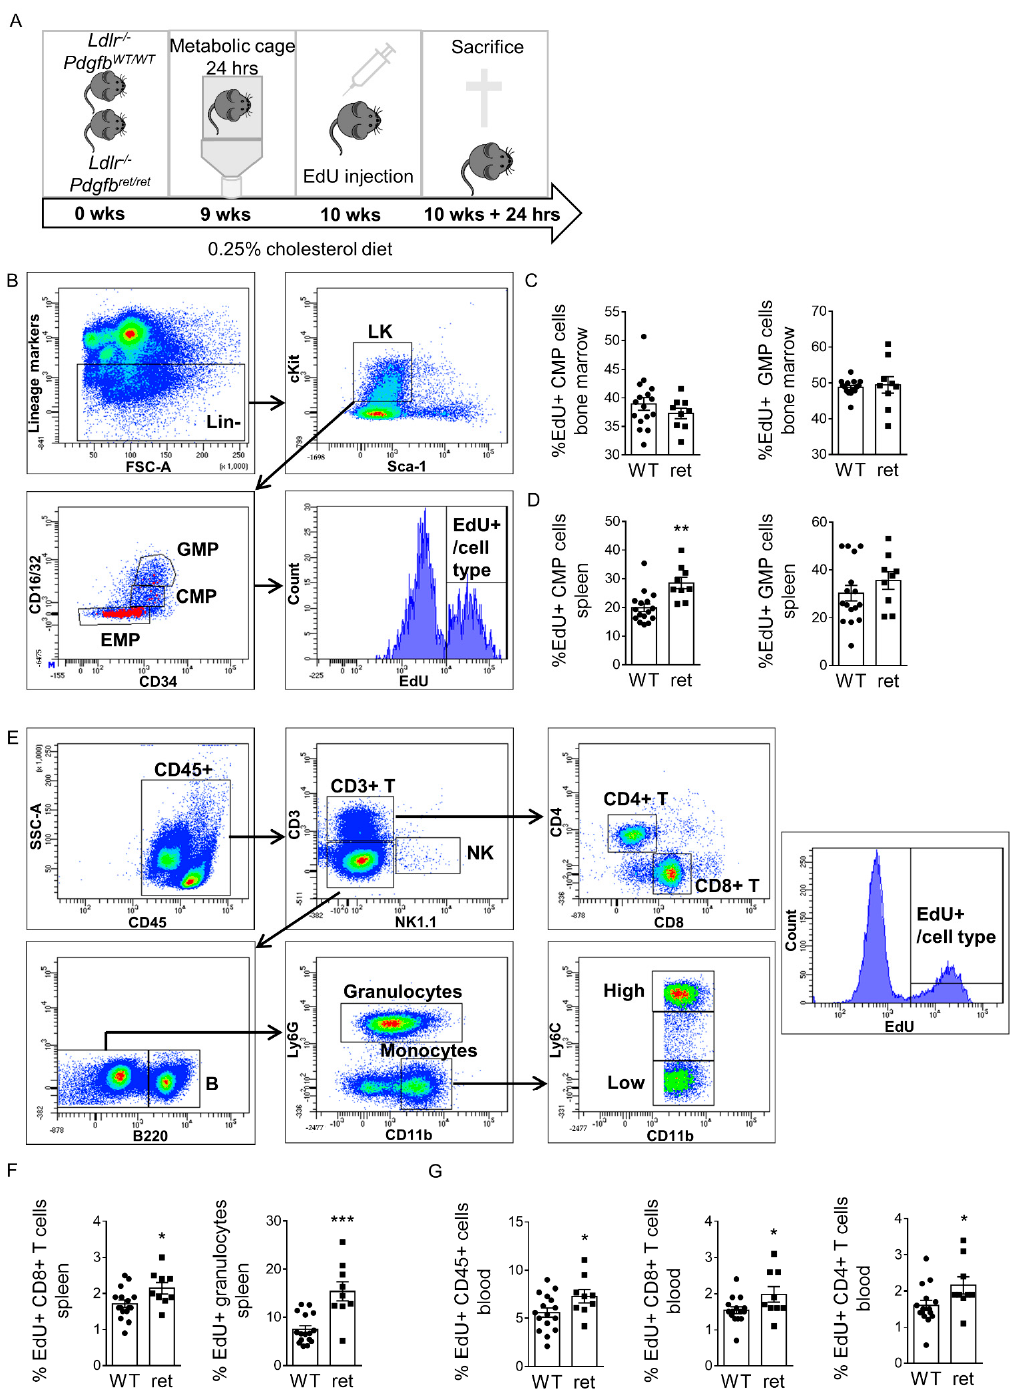
Figure 5. Increased extramedullary hematopoiesis and proliferation of leukocytes in Pdgfb ret / ret mice. ( A ) Setup of second mouse experiment using Ldlr -/- Pdgfb WT / WT ( n = 16) and Ldlr -/- Pdgfb ret / ret ( n = 9) mice. ( B ) Flow cytometry gating strategy to assess hematopoietic progenitor cells and 5-ethynyl-2 (cid:48) -deoxyuridine (EdU) incorporation. ( C ) Percentage of EdU positive progenitor cells in Pdgfb WT / WT ( n = 16) and Pdgfb ret / ret ( n = 9) bone marrow and ( D ) spleen. ( E ) Flow cytometry gating strategy to assess leukocytes and EdU incorporation. ( F ) Percentage of EdU positive leukocytes in Pdgfb WT / WT ( n = 15–16) and Pdgfb ret / ret ( n = 9) spleen and ( G ) blood. Graphs represent mean ± SEM. * p < 0.05, ** p < 0.01, *** p < 0.001. Data were tested for normality (Shapiro-Wilk) and equal variances (F-test). Variables that did or did not pass were analyzed using Student’s t -test or the Mann-Whitney U test,